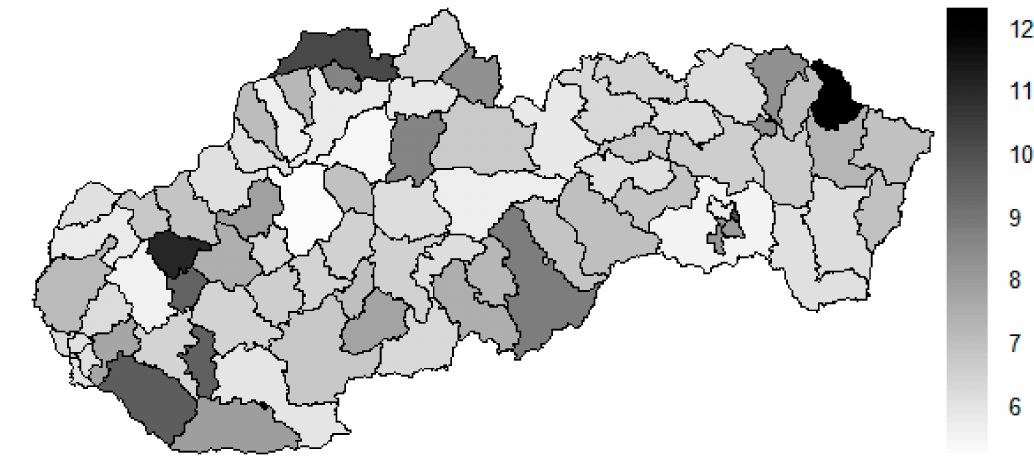
Figure 20. Preventable mortality similarity map of the districts for the female sex in the year 2015. Source: own elaboration by the authors.